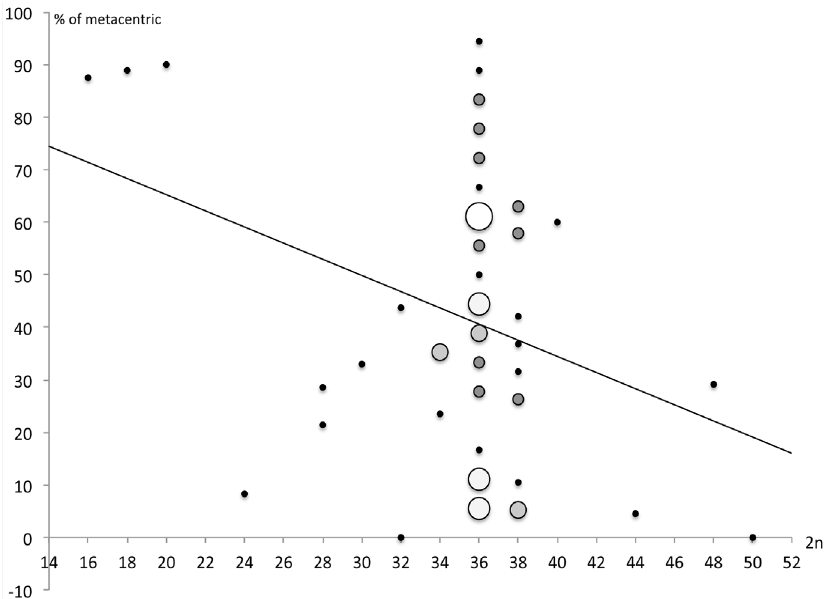
Figure 3. Scatter-plot of a diploid chromosome number (2n) and proportion of metacentric chromo- somes with overall regression line. The diameter and color of circle indicate number of species from 1 to